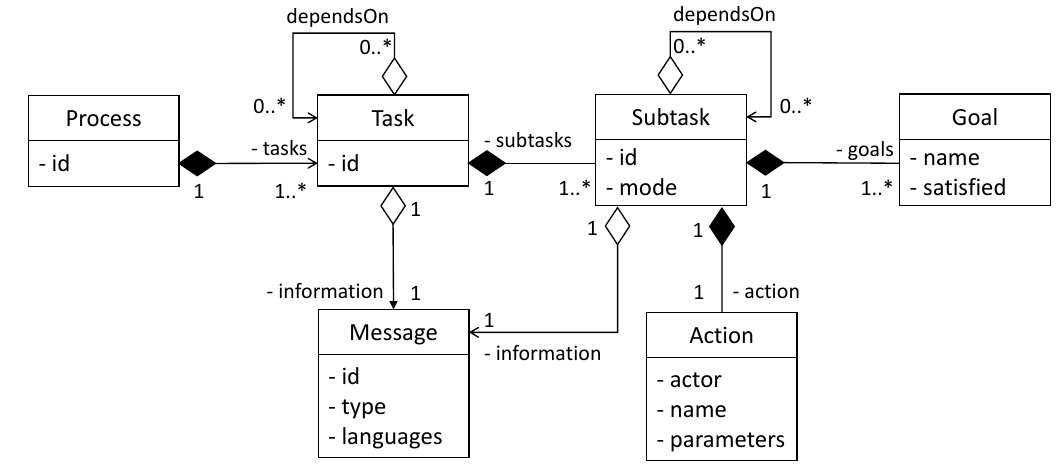
Figure 2. UML class diagram of the process data model.